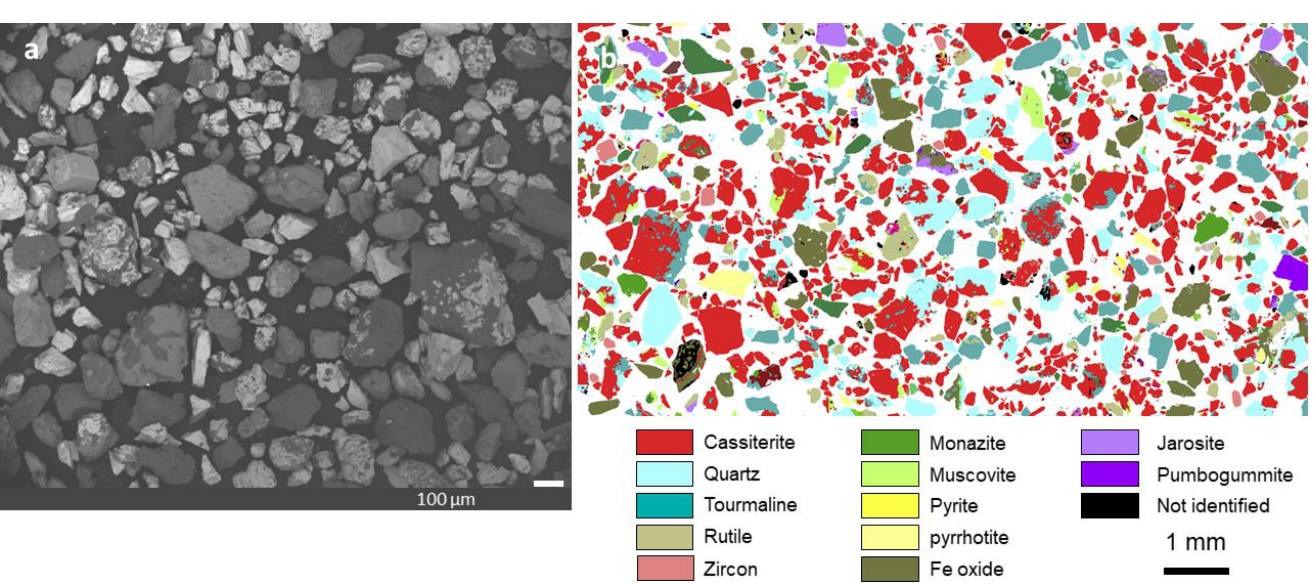
Figure 6. ( a ) SEM images of the concentrate 2 from Catavi; the lightest color is cassiterite. ( b ) False colour MLA map of the concentrate 2. Table 3. Modal mineralogy provided by the MLA of concentrate 2 from Catavi. Iron oxides and hydroxides represented 10.44 wt.% and rutile 4.6 wt.%. Sulfides were not abundant, and pyrite pyrrhotite, arsenopyrite, galena, sphalerite and stannite occurred in minor